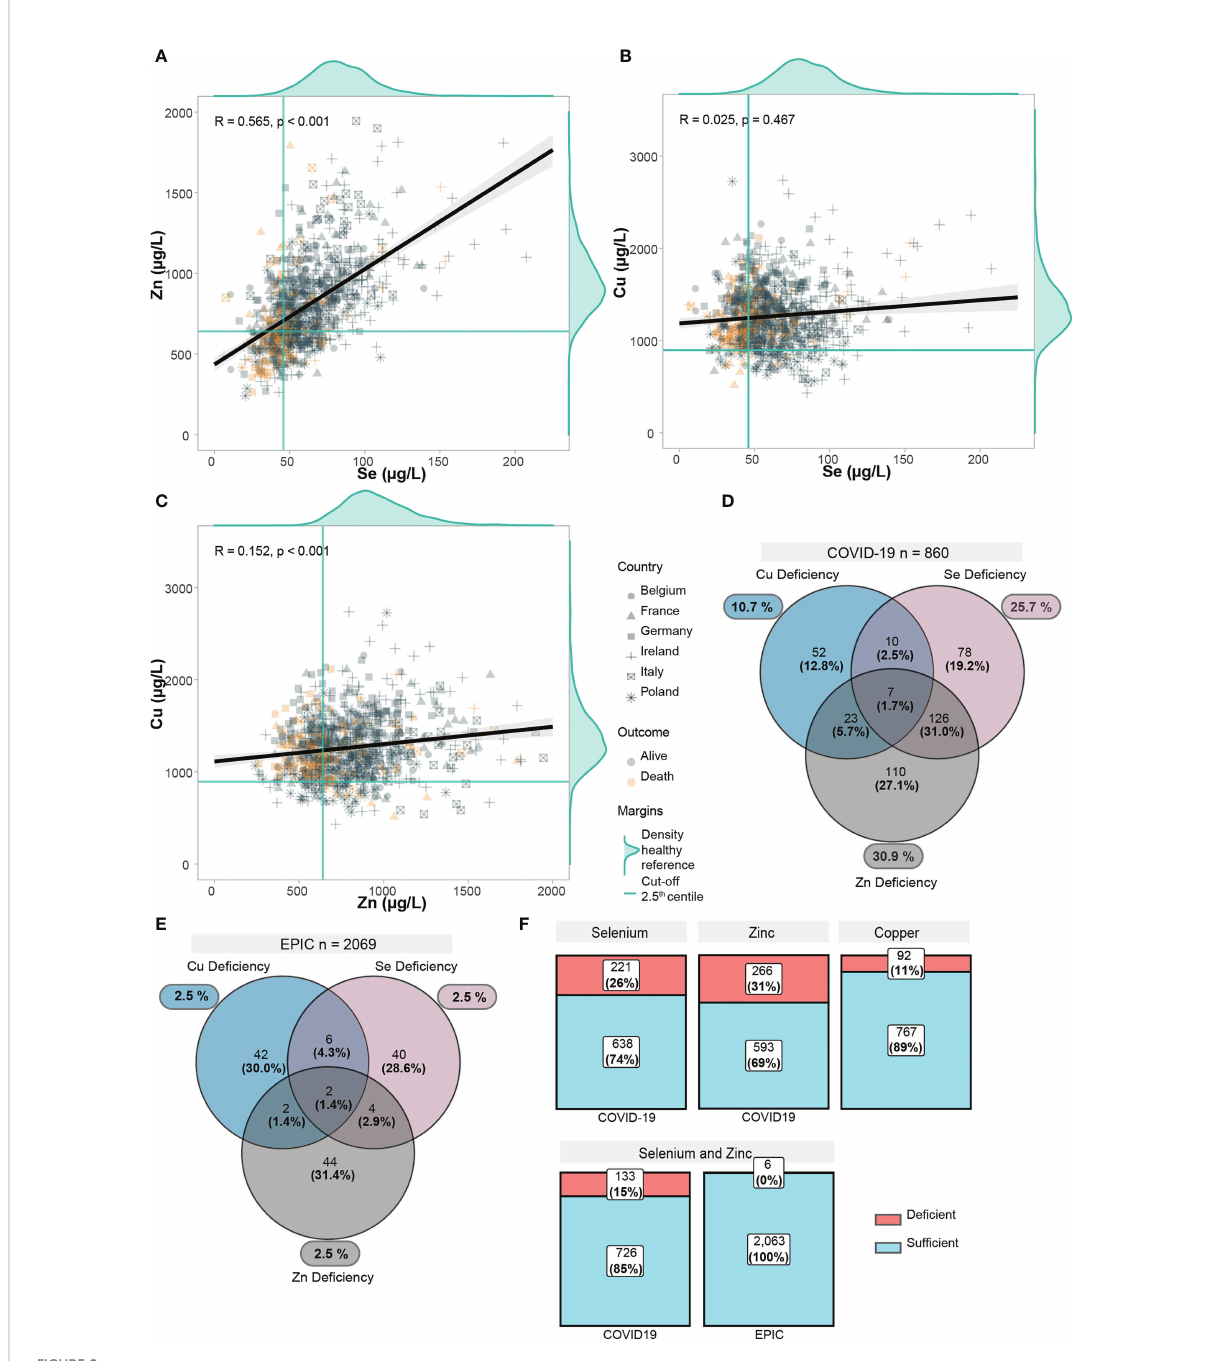
FIGURE 2 Trace element status in relation to each other and EPIC-reference cohort. (A – C) Scatter plots displaying the correlation between trace elements in COVID-19 positive patients. Yellow points display deceased patients, grey points display alive patients. Point shapes differ according to each country. For each trace element, the distribution of the healthy EPIC-cohort (n=2069) was plotted as marginal density plots. Green lines correspond to the 2.5 th lowest centile in the EPIC-cohort. Black line is computed using linear regression, gray shadows correspond to 95% con fi dence intervals. Correlation coef fi cient (R) was computed with the Spearman ’ s R. (D) De fi ciencies in trace elements (below 2.5 th centile in EPIC) are shown. Venn diagram shows overlapping/combined de fi ciencies. (E) De fi ciencies in trace elements are shown in the EPIC cohort. (F) Proportions of de fi ciency in each trace element as well as a combined Se and Zn de fi ciency are